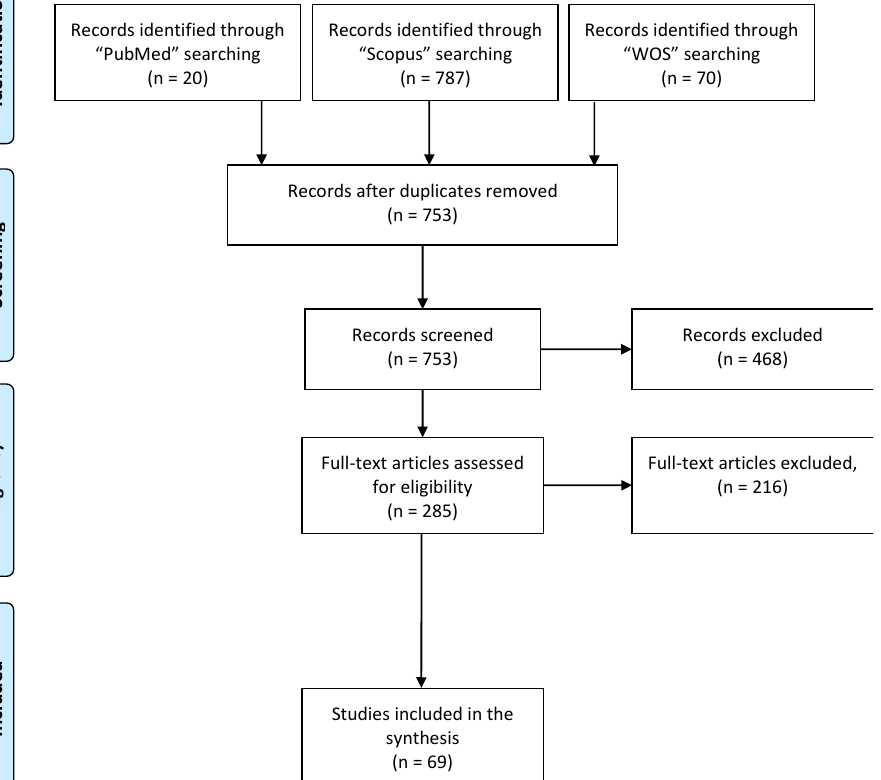
Figure 1. PRISMA flow diagram of the systematic review process.